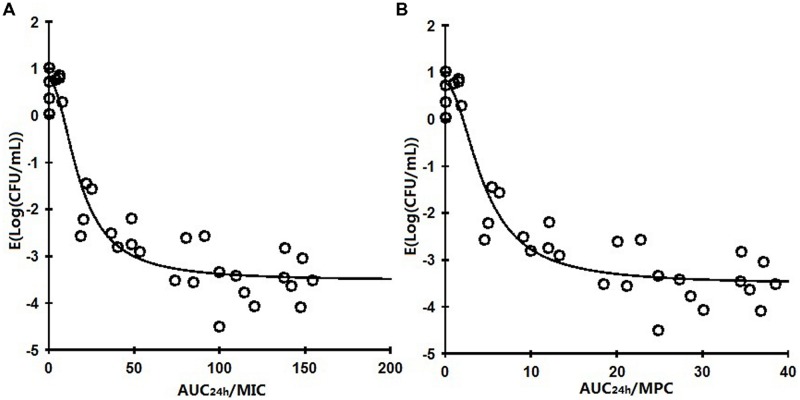
Plots of AUC24h/MIC or AUC24h/MPC ratio versus the difference of bacterial counts (Δlog10 CFU/mL) for Pasteurella multocida (CVCC1669) 24 h after i.m administration at various doses in the infected tissue-cage. The line represents the curve of predicted values, based on the Sigmoid Emax model, and the circles are the values for the individual tissue-cage.